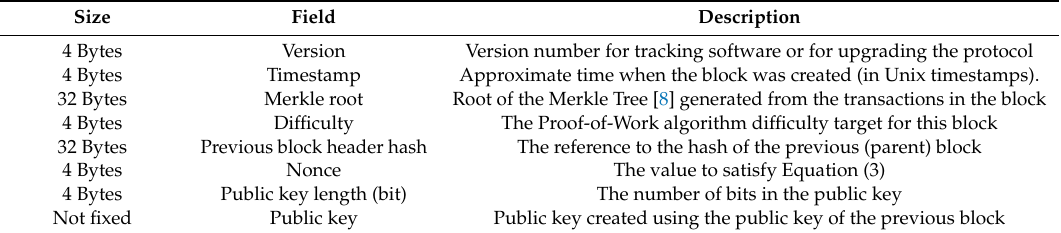
Table 3. Structure of the header part in the block of the time-release